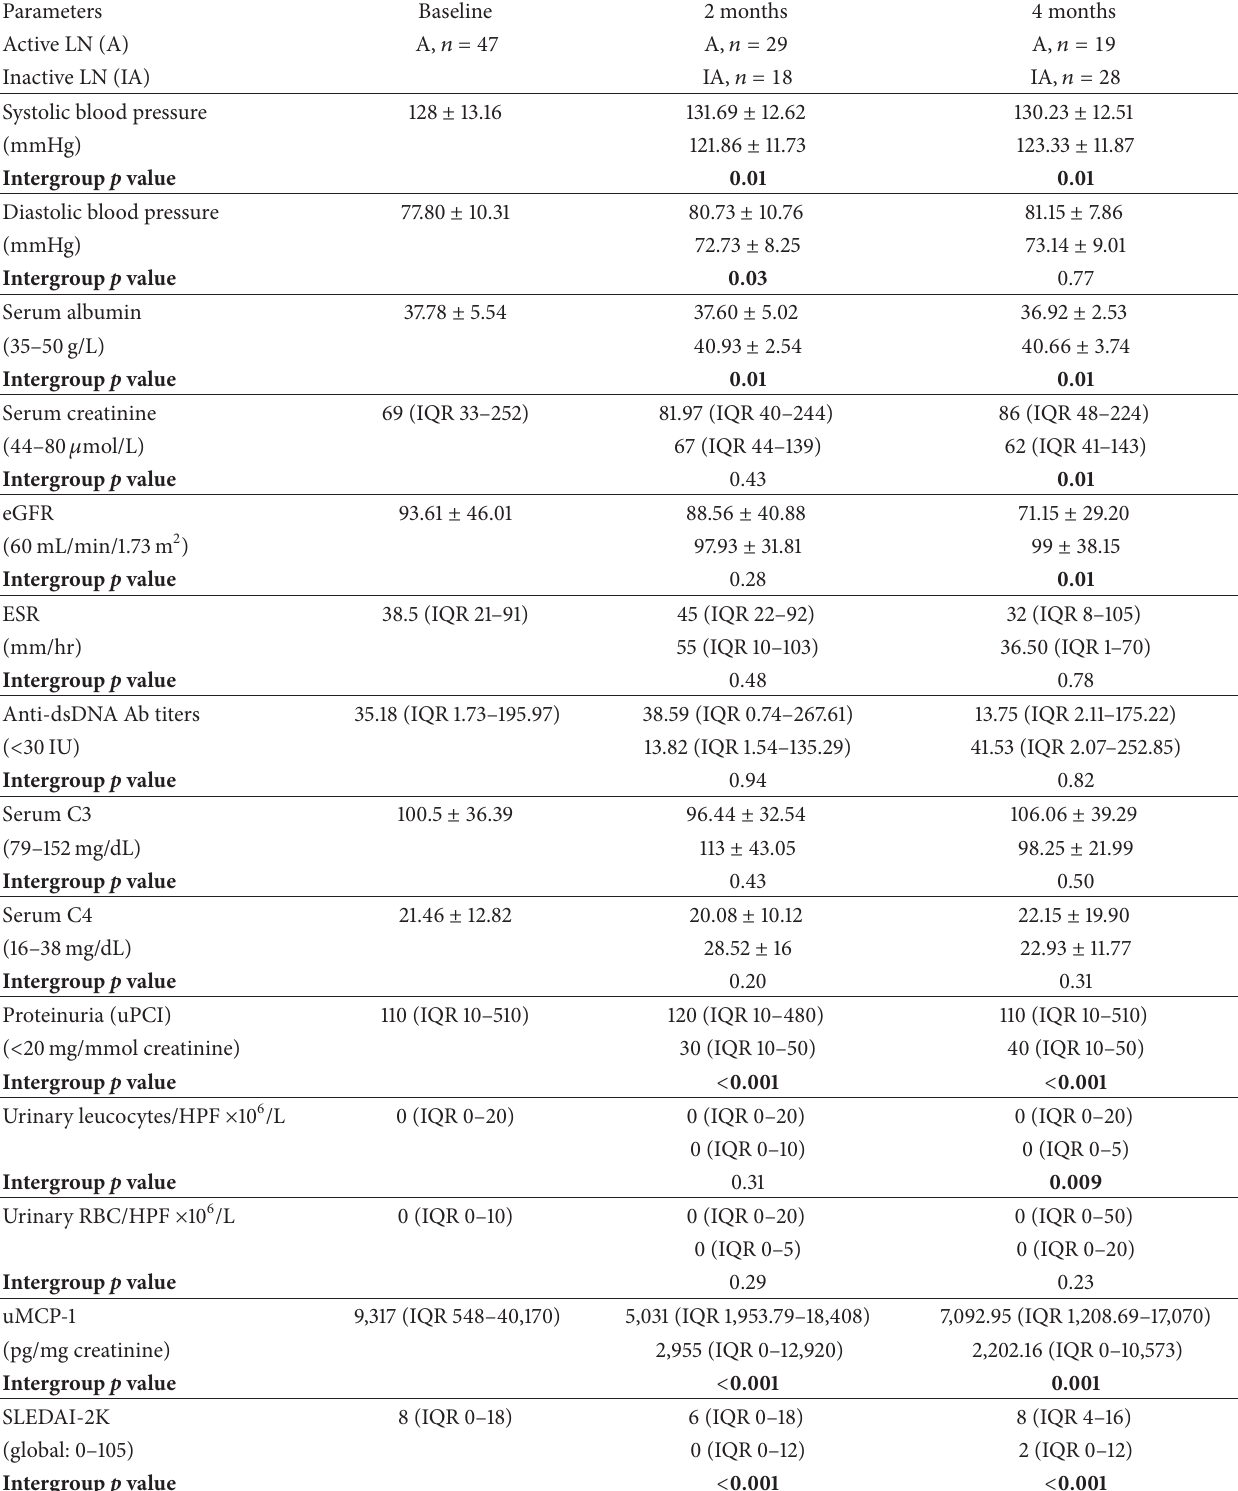
Table 5: Follow-up characteristics of the patient subgroup with LN active at